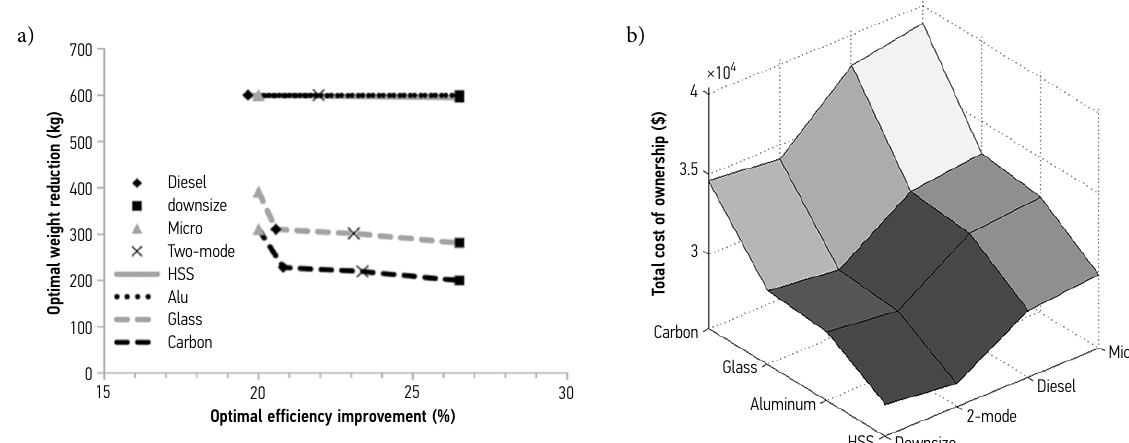
Fig. 9. Optimal levels of efficiency and lightweighting technology implementation for the sixteen marginal cost scenarios (a) and total cost of ownership